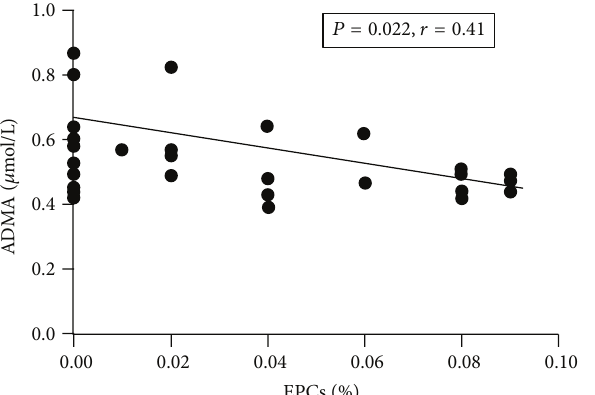
Figure 4: Correlation between mean EPCs and ADMA serum levels in RA patients. EPCs: endothelial progenitor cells, ADMA: asymmetric asymmetric dimethyl